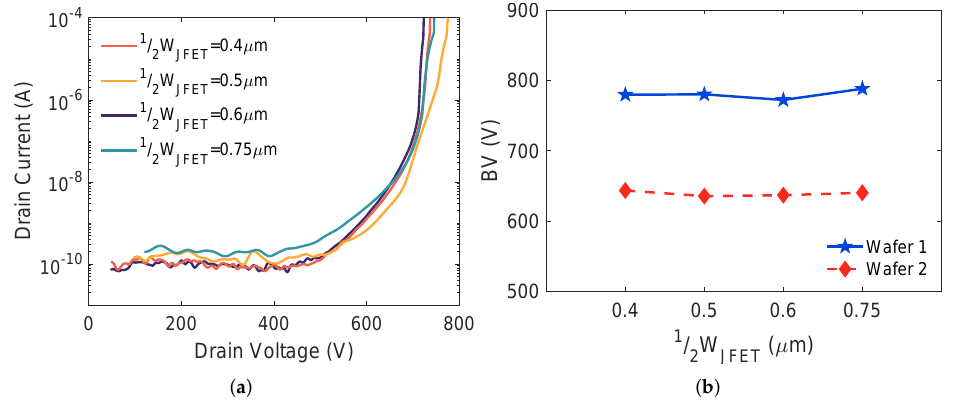
Figure 5. ( a ) Measured blocking characteristics of the SiC MOSFETs on wafer 1 and ( b ) Maximum BV as a function of 1 W JFET for MOSFETs on wafers 1 and 2